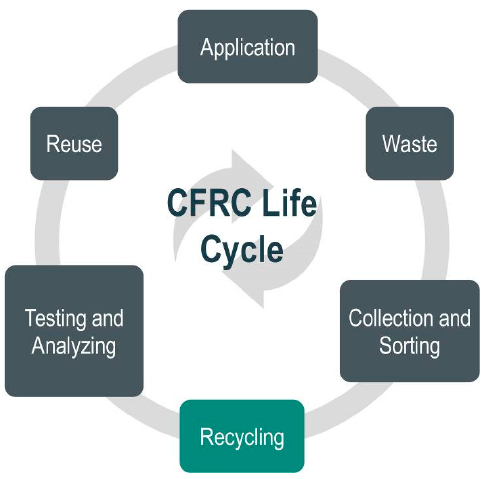
Figure 1. A scheme of carbon fiber-reinforced composite (CFRC) life cycle.